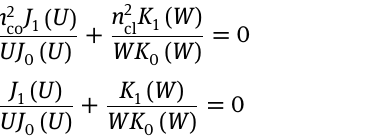
Figure 2: Sketch map of the focusing process of